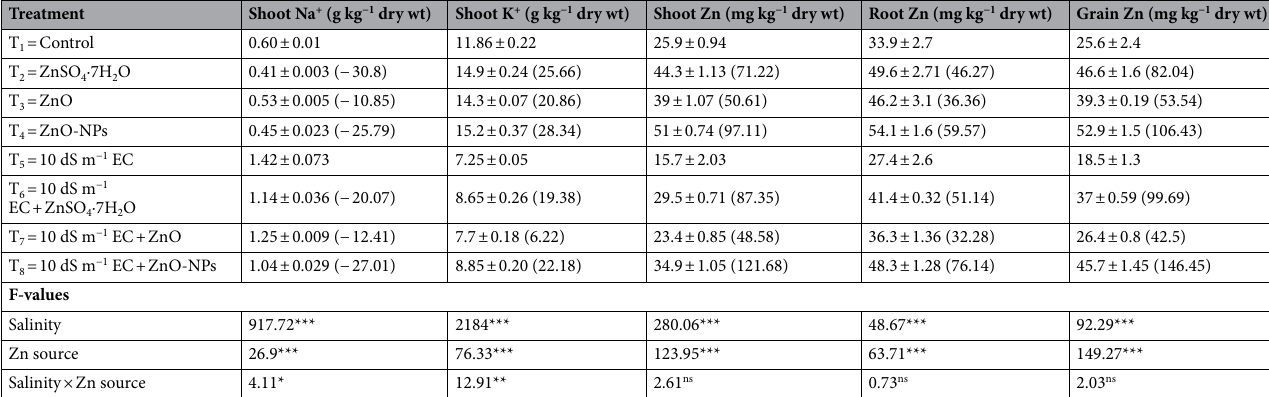
Table 4. Comparative effect of ZnO-NPs to other bulk Zn sources on salt tolerance attributes (g kg −1 dry wt) and Zn concentration (mg kg −1 dry wt) of wheat. Values represent mean ± SE (n = 3). Values in parenthesis show percent increase or decrease from respective control. According to LSD test with multiple comparisons, F-values of the Two-way ANOVA are indicated as: ns not significant. *Significant at p ≤ 0.05. **Significant at p ≤ 0.01. ***Significant at p ≤